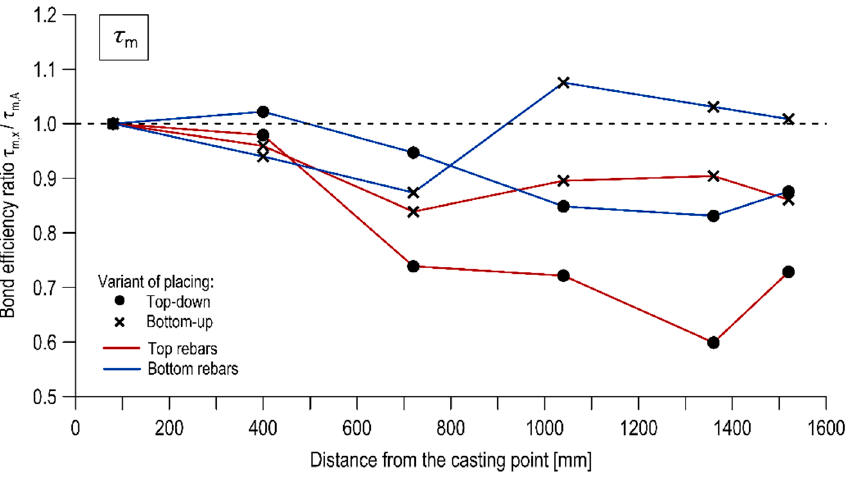
Figure 10. Bond efficiency ratio as a function of rebar position for the mean bond stress. Figure 10. Bond e ffi ciency ratio as a function of rebar position for the mean bond stress.